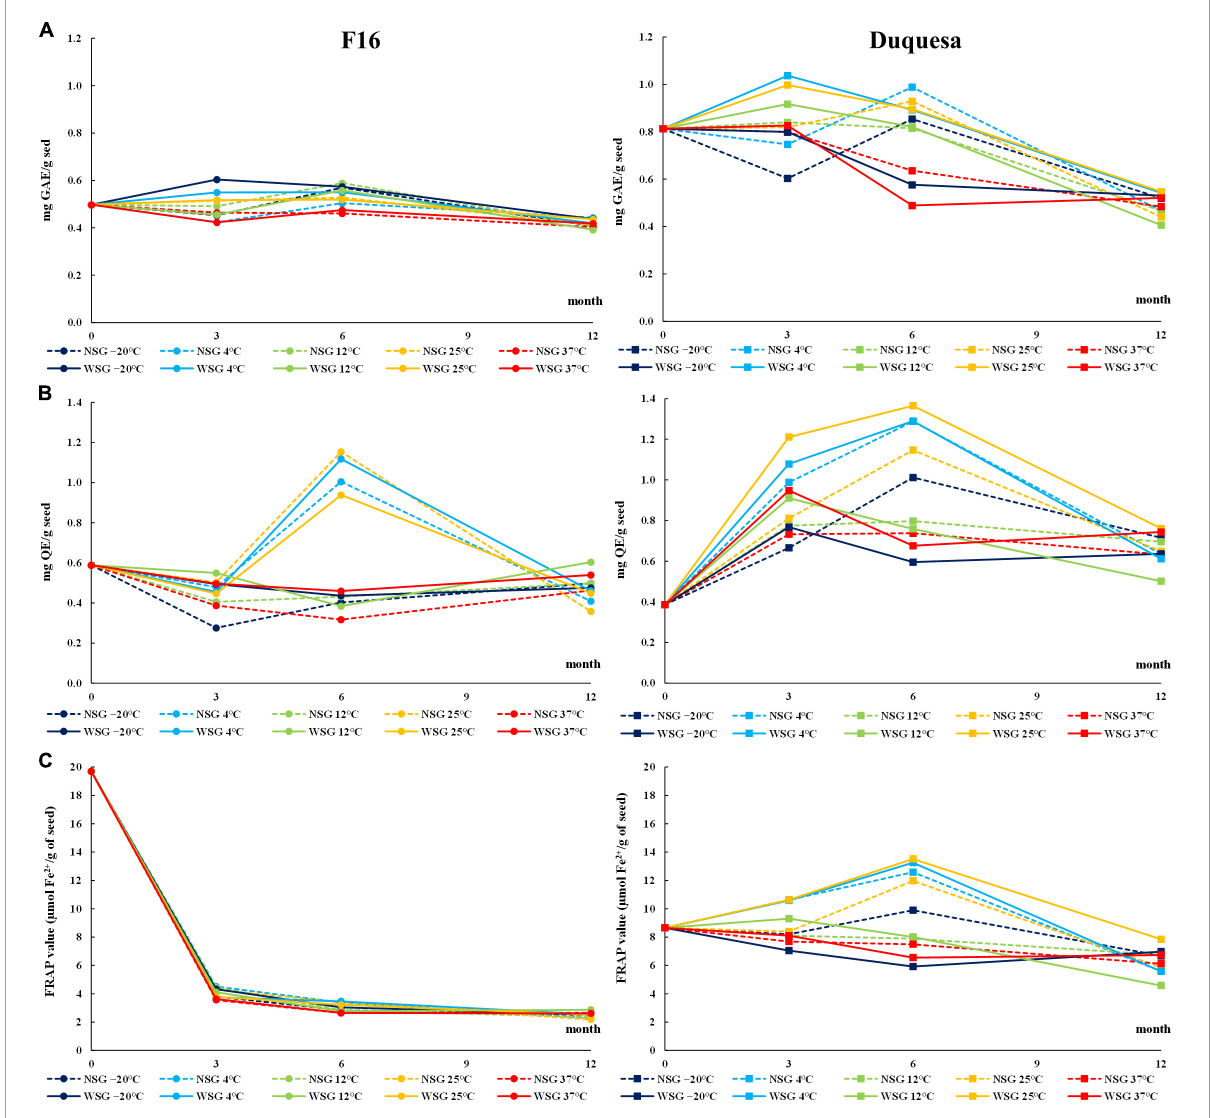
FIGURE4 Antioxidant evolution over storage time. (A) Total phenolic contents (TPC) over storage time in F16 (left) and Duquesa seeds (right), measured in gallic acid equivalents (GAE) through the Folin-Ciocalteu method. (B) Total flavonoid content (TFC) measured in quercetin equivalents (QE) through the AlCl 3 method. (C) Antioxidant capacity of quinoa seeds measured through the FRAP assay expressed as amount of Fe 2 + ions reduced in seeds. NSG, seeds stored without silica gel; WSG, seeds stored with silica